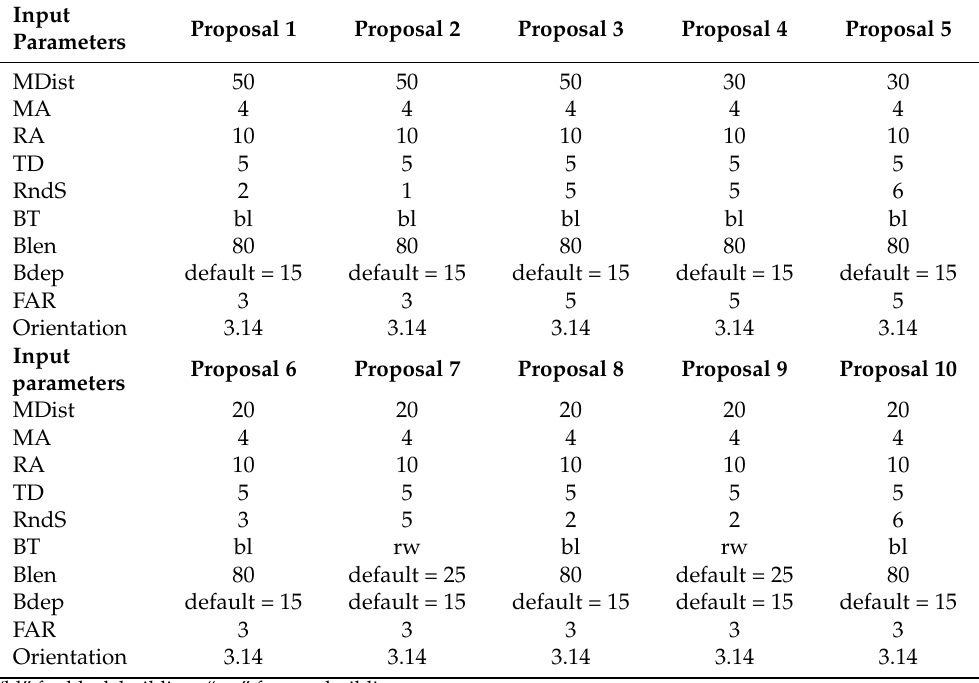
Table 4. Input parameters of 10 representative urban design